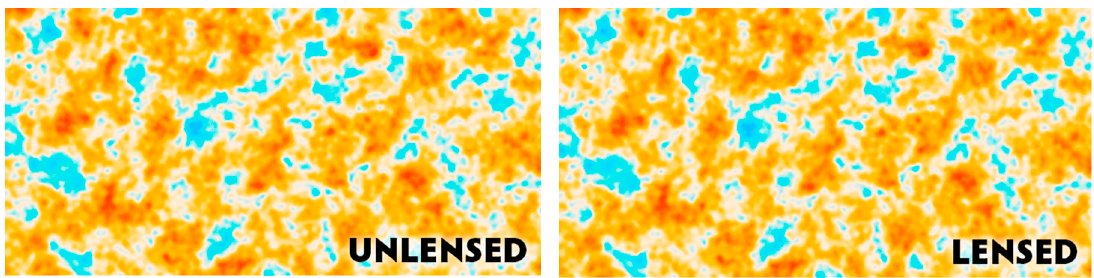
Figure 22. CMB Lensing: This illustration shows how CMB photons are deflected by the gravitational lensing effect of massive cosmic structures as they travel across the Universe. Image credit: ESA/NASA/JPL-Caltech. To appreciate in more detail the differences see a blinking gif at